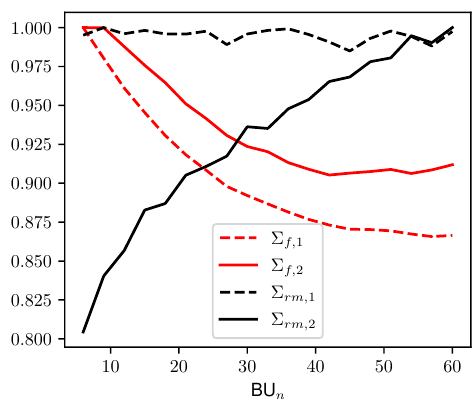
Figure 7. Mean behavior of HXS during burnup using α parameter from Equation (4). α demonstrates an estimation for the behavior of the HXS if all state variables were set to their mean value over the entire